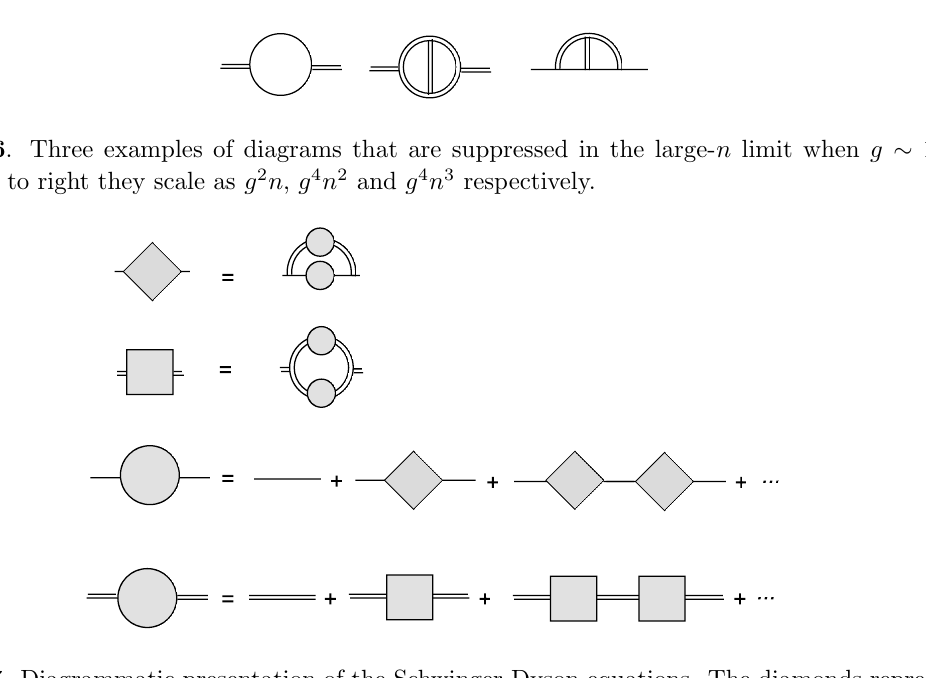
Figure 5 . Fundamental building blocks for the (left) and (cid:31)(cid:31) (right) 2-point functions (and their super-descendants) at large n . Each of these two diagrams scales as g 2 n 2 .